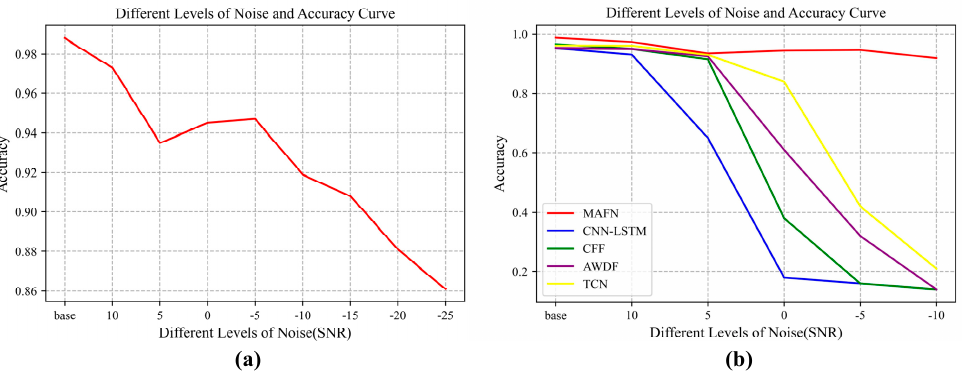
Figure 6. The classification accuracy curves of MAFN and its counterparts under different SNRs. ( a ) Accuracy curve of MAFN with different SNRs. ( b ) Accuracy curve of comparison methods.